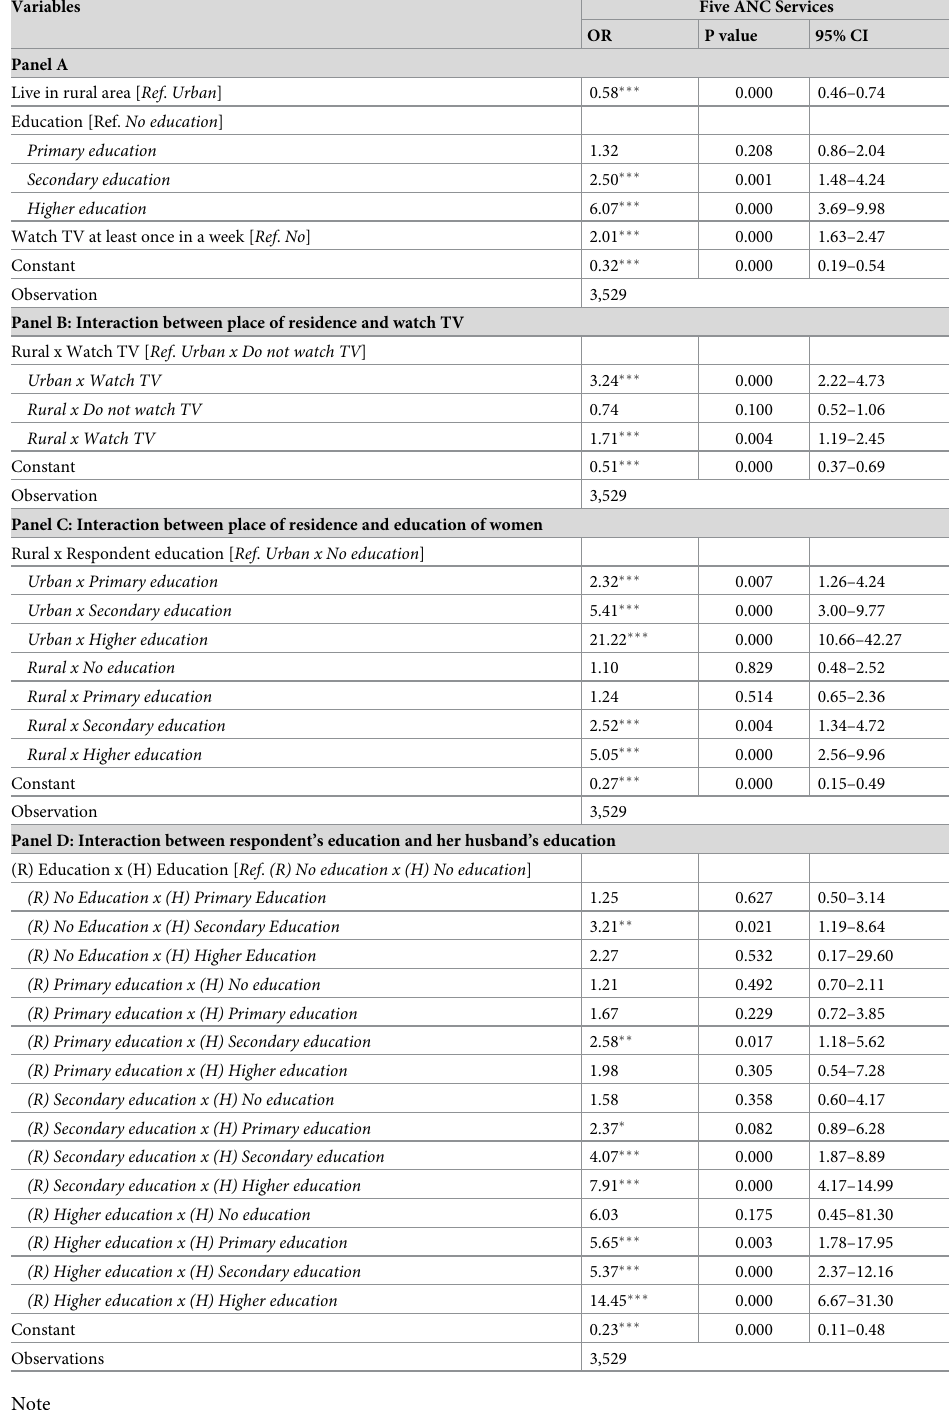
Table 5. Heterogeneity in factors influencing access to and utilization of five ANC